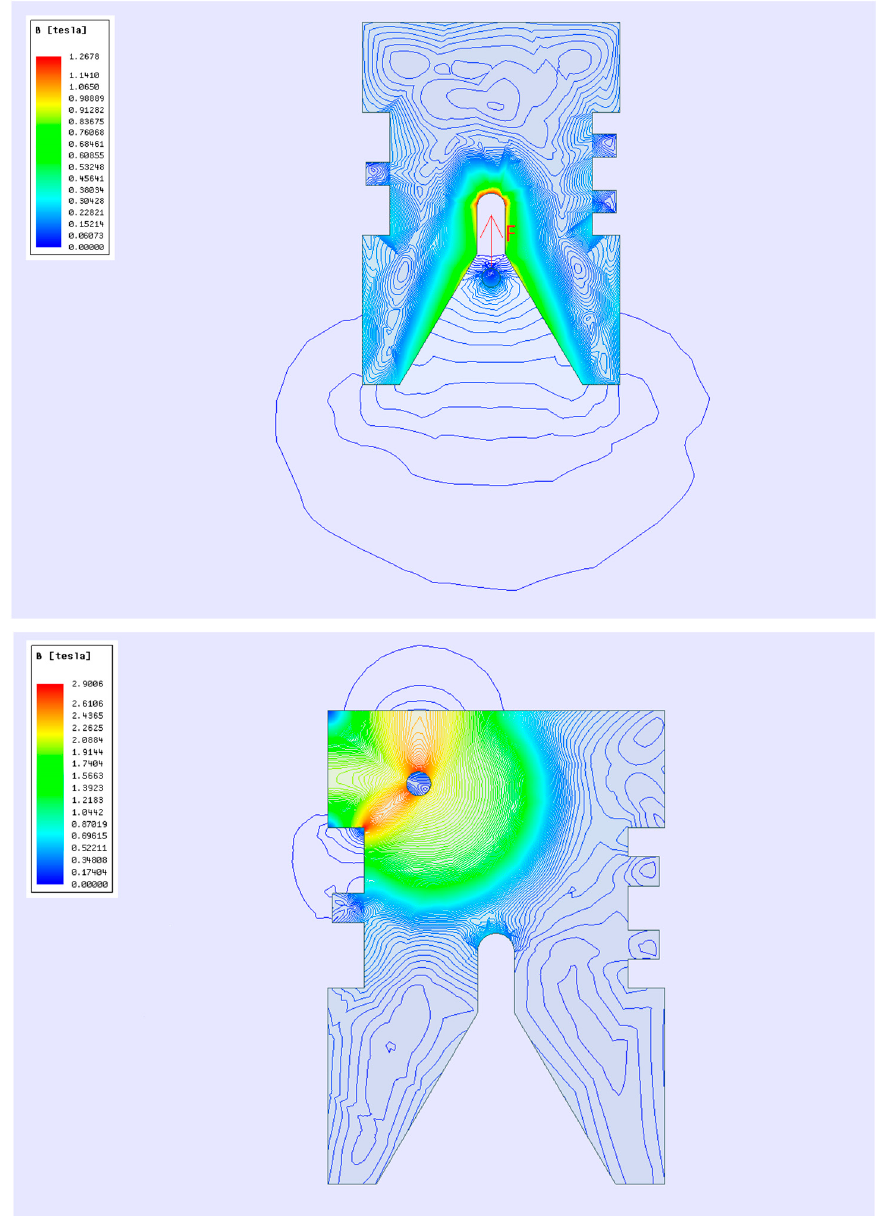
Figure 12. The distributions of the electromagnetic induction values for different positions of the electric arc in the cutouts of the extinguishing chamber plate determined by the use of the ANSYS software.